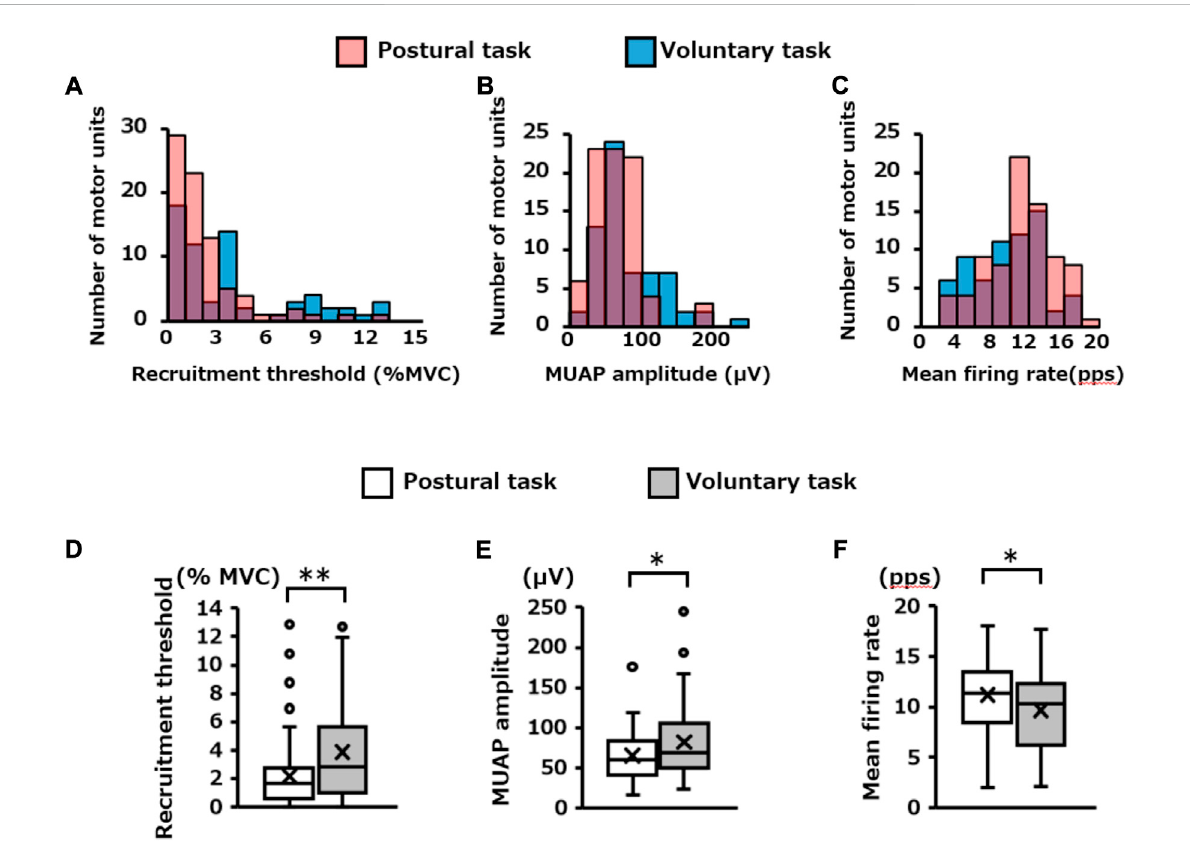
FIGURE 7 Firingpropertiesofindependentlyextracted motorunits foreachmotor task.Thehistogramintheupperpanel shows thedistributionofthe (A) recruitmentthreshold, (B) MUAPamplitude, and (C) mean fi ringrate for the pooled motor units extracted independently ineach motor task. The red andbluebarsindicatetheresultsoftheposturalandvoluntarytasks,respectively,andthepurpleareasindicatetheoverlapbetweenthetwo.Thebox plots at the bottom show the statistical results (Mann – Whitney U Test) for each of them (D,E,F) . * p < 0.05, ** p < 0.01.